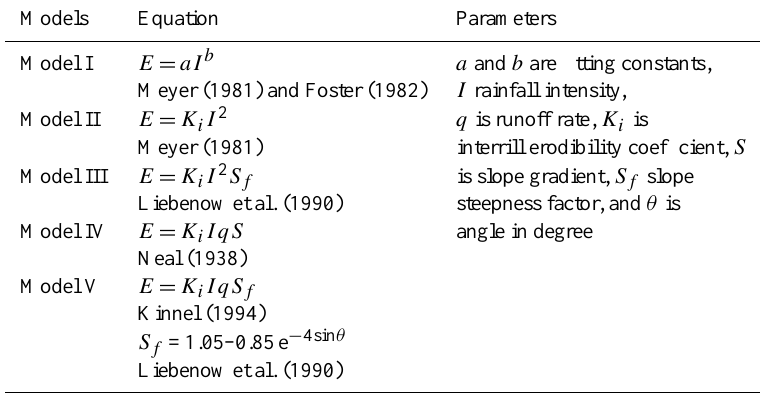
Table 1. Available interrill erosion models and slope steepness factor. Models